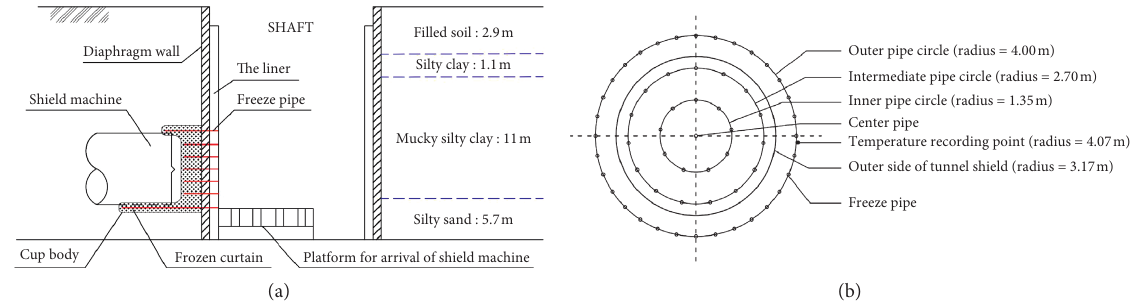
Figure 1: Layout diagram of horizontal freeze pipes in and out of shield tunnel: (a) longitudinal sectional view; (b) cross-sectional view.